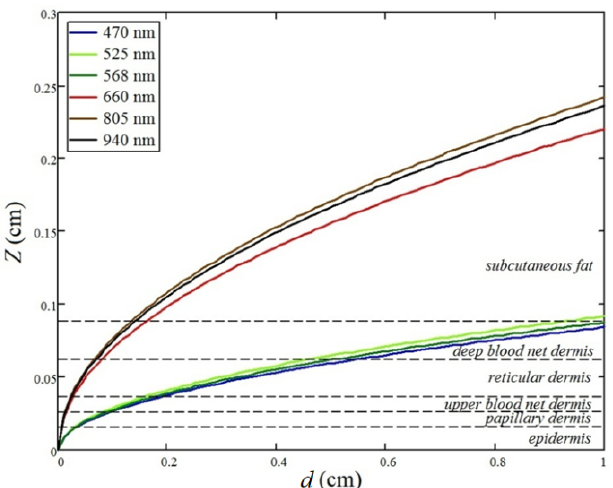
Figure 4. Dependence of the mean penetration depth Z on the source–detector distance d for different wavelengths. Z was calculated for the single-layer medium model. The dotted lines show the depth of real skin layers for better visualization and understanding.